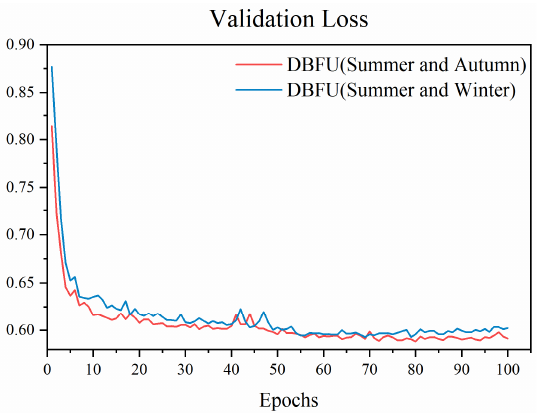
Figure 15. Comparison of validation loss of different seasonal combinations of images (Y-axis: the value of the validation loss in training process).